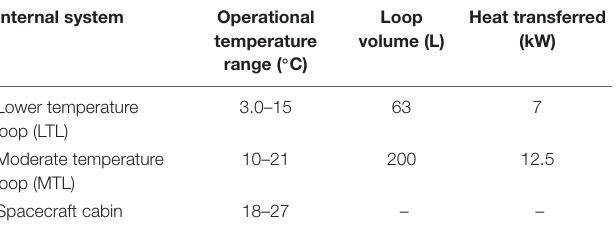
TABLE 1 | Internal active thermal control system and crewed cabin operational characteristics (The Boeing Company, 2001; Valenzano et al., 2003; Anderson et al.,